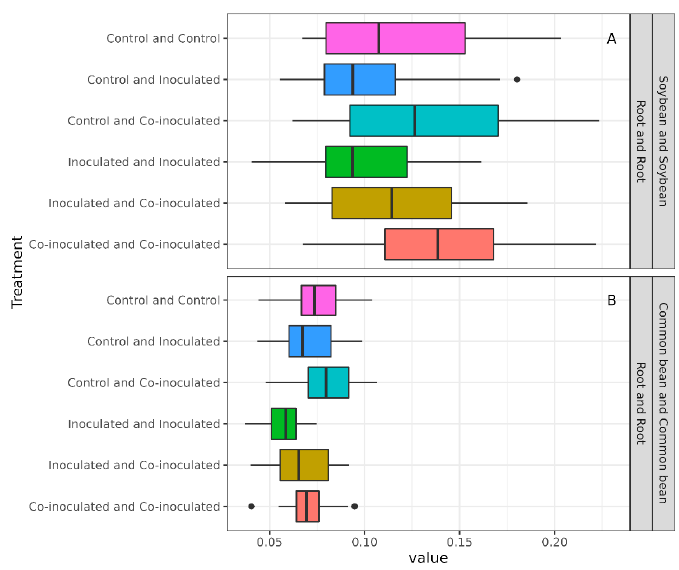
Figure 8. Bacterial weighted UniFrac beta diversity distances in the microbiomes of roots and nod- ules of common bean and soybean non-inoculated (control). Inoculated with specific rhizobia, and co-inoculated with rhizobia and Azospirillum brasilense.